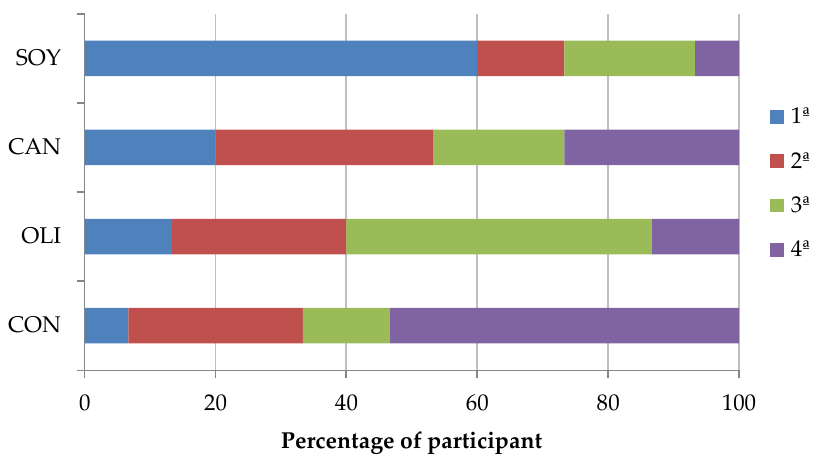
Figure 3. Preference attributed by the panelist on dry-fermented deer sausages.